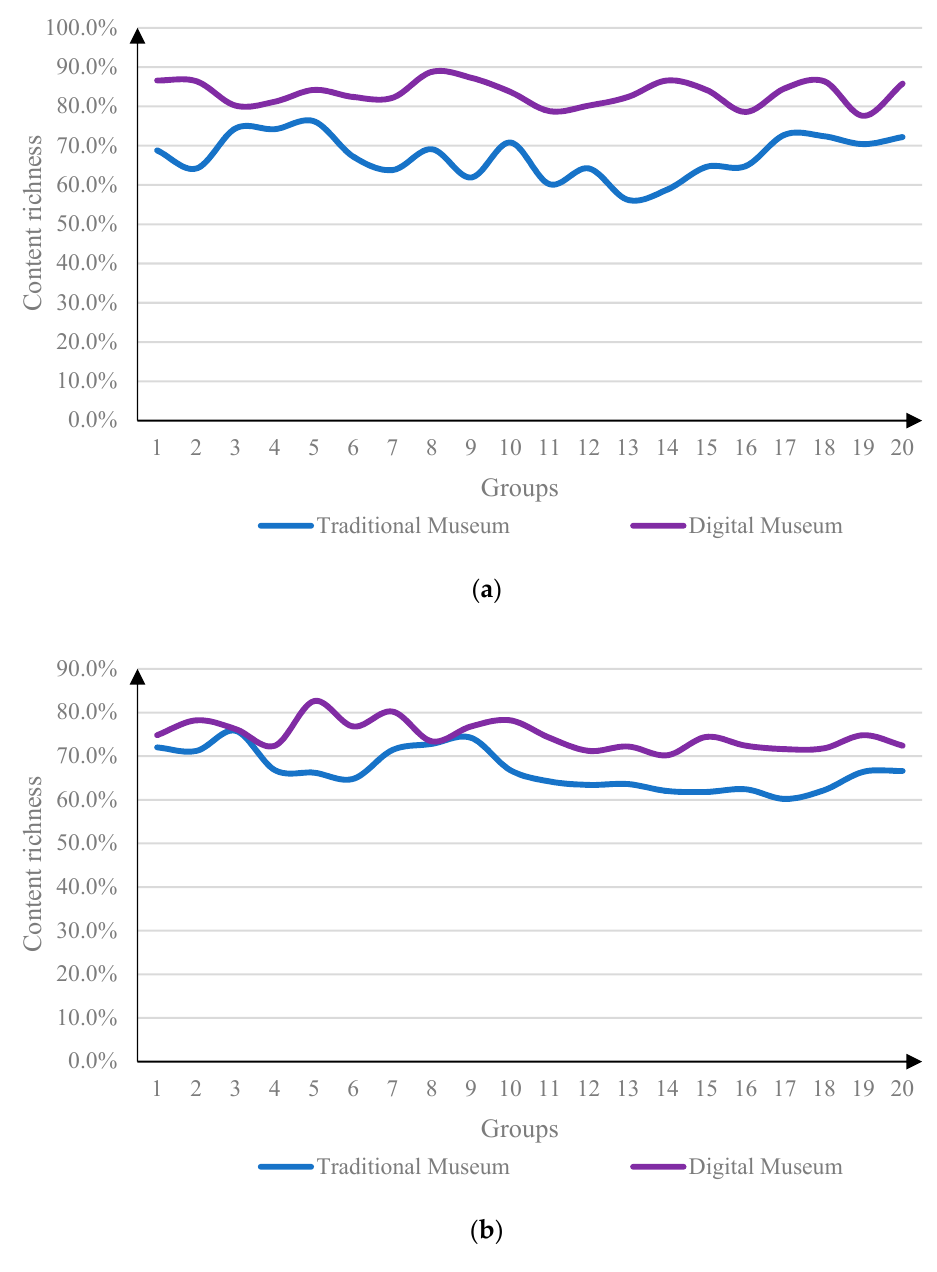
Figure 8. Comparison results of content richness. ( a ) The richness of museum content from the perspective of young people, ( b ) The richness of museum content from the perspective of the elderly.